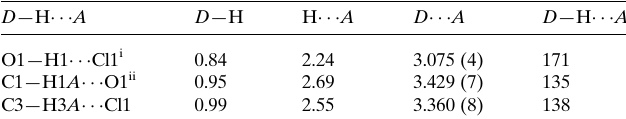
Table 1 Hydrogen-bond geometry (A˚ , (cid:2) ). D —H (cid:5)(cid:5)(cid:5) A